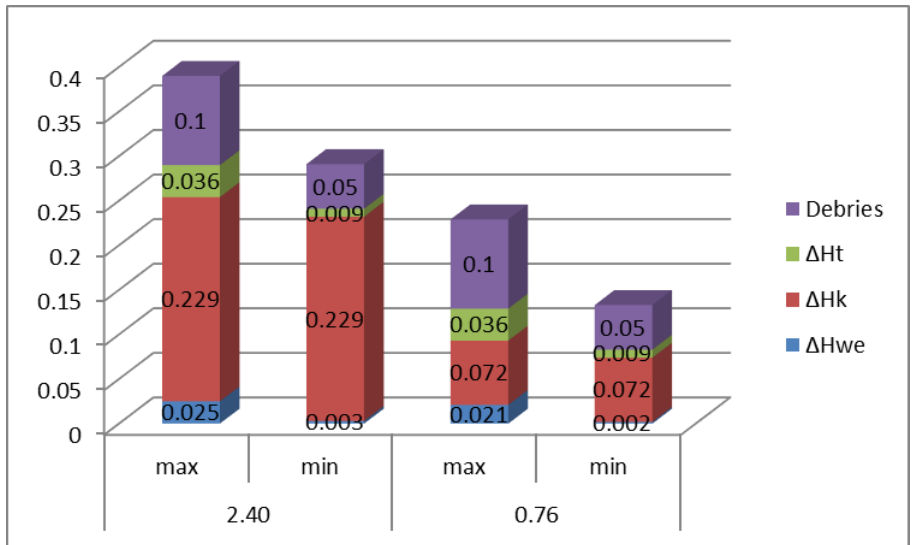
Figure 3. Total losses for two different coefficients β.